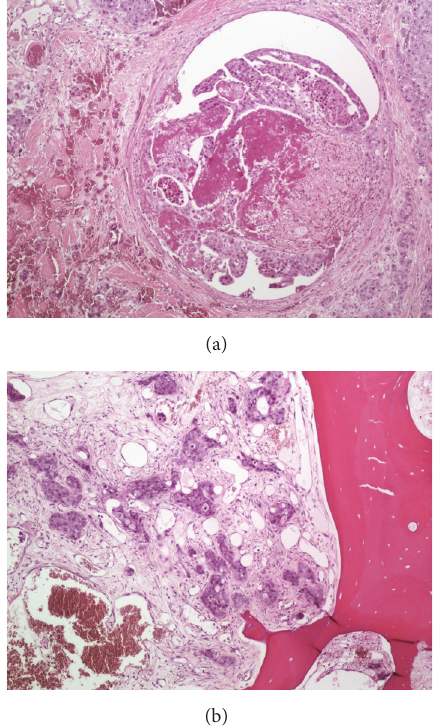
Figure 7: In the amputation specimen, the ADPA was found to be present within vascular spaces (a) as well as within the bone (b) (H & E, original magnification